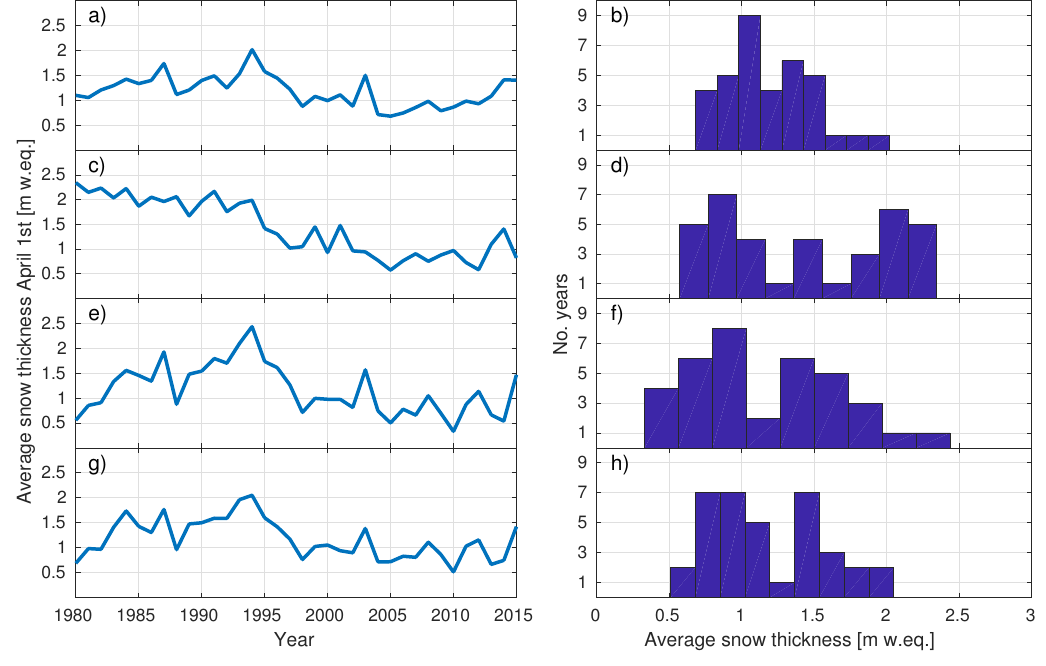
Figure 6. Time series and histograms of the mean modeled snow thickness on 1 April below 1300 m for ( a , b ) Vatnajökull; ( c , d ) Brúarjökull; ( e , f ) Síðujökull; and ( g , h ) Skaftá GWC. Brúarjökull terminates at 600 m a.s.l., Síðujökull at 650 m a.s.l. and Skaftá GWC at 740 m